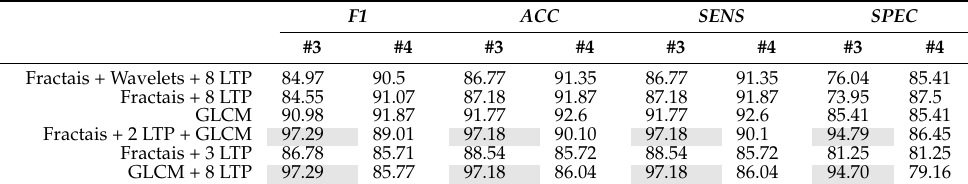
Table 11. Experiments 3 and 4 evaluated by other performance indices.